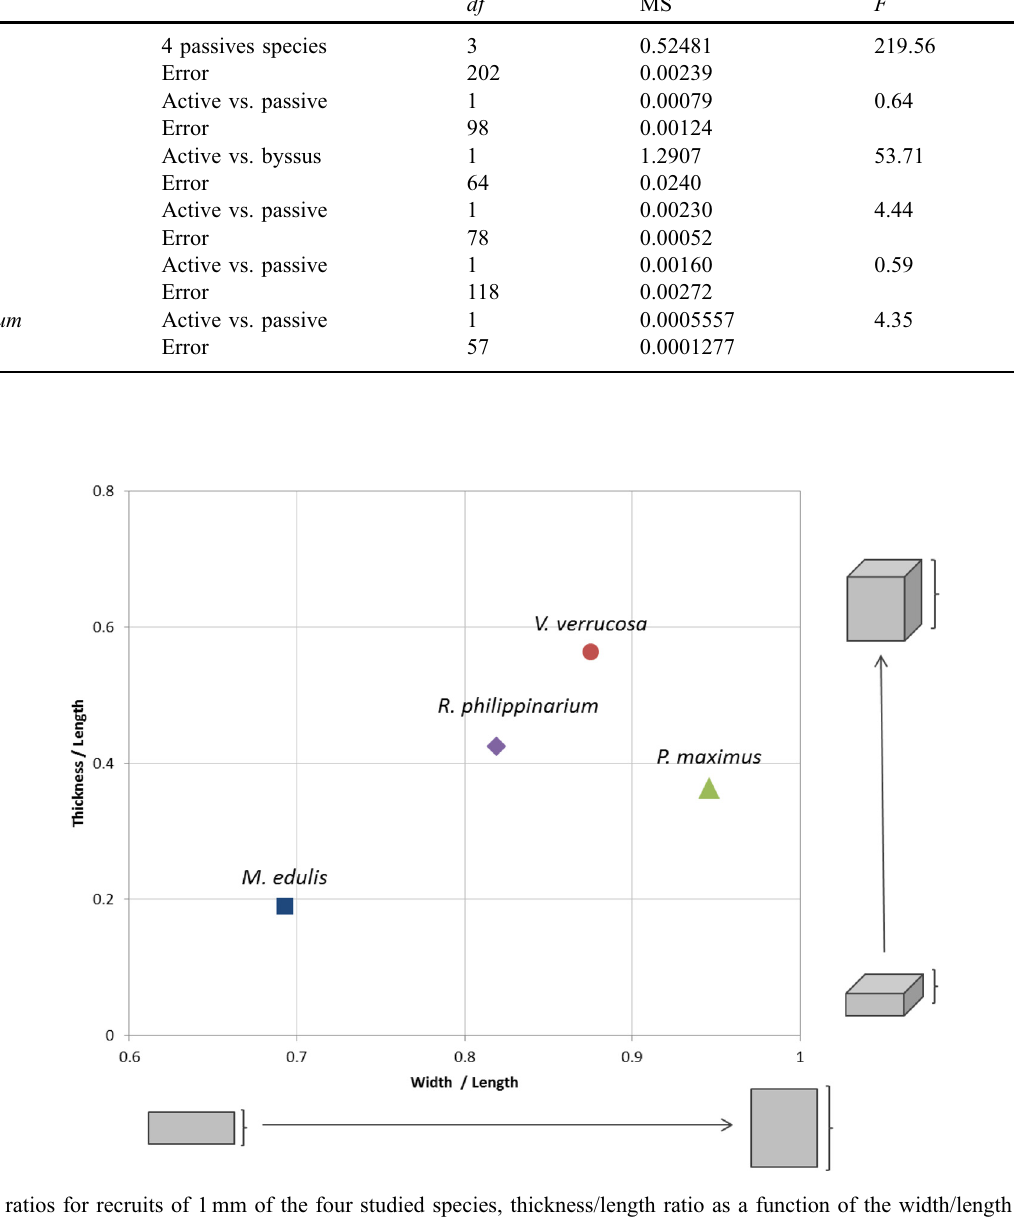
Table 1. results of Ancova analyses performed on sinking velocity between passive batches of the 4 species, between active and passive batches for each of the 4 species and between active mussel recruits producing or not byssus, with individual volume as cofactors. Species df MS F P All (x4)